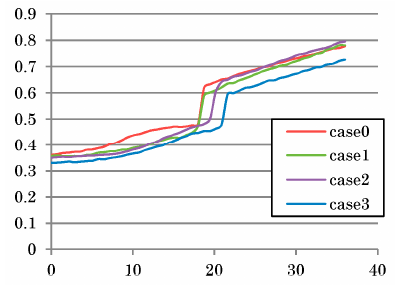
Figure 7. Drag coefficients at Re = 1.0 × 10 5